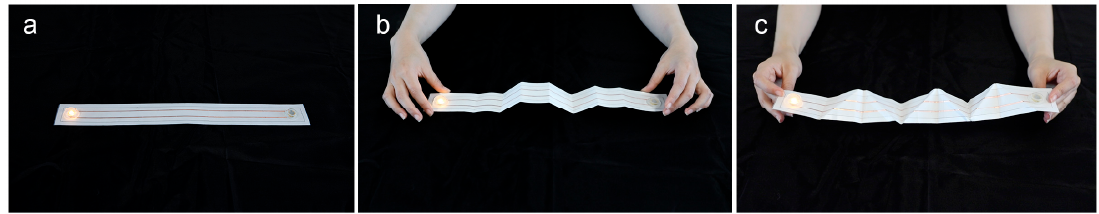
Figure 13. ( a ) Paper interface for foldability test; ( b ) vertical folding; and, ( c ) tilted folding.